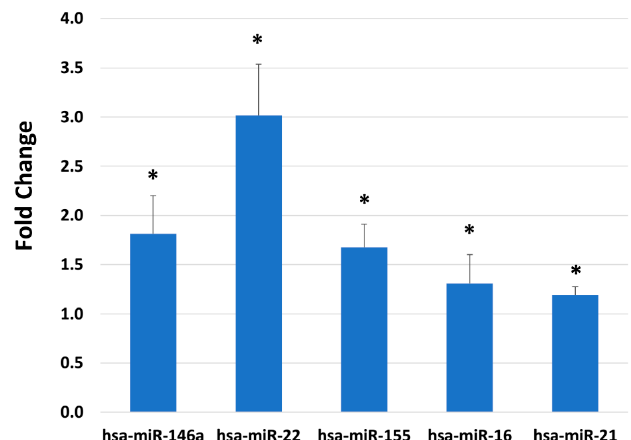
Figure 4. Epigenetic expression modulation. Skin equivalents were dosed with BlendIP for 24 h for microRNA expression. One hundred five validated targets with seven endogenous controls were examined in an OpenArray format. Standard deviation is shown as error bars. Unpaired t -tests were performed using StatMiner, and all data shown are statistically-significant from the untreated ( p ≤ 0.05). Only selected microRNAs are shown. * indicates statistically-significant increase compared to control values.